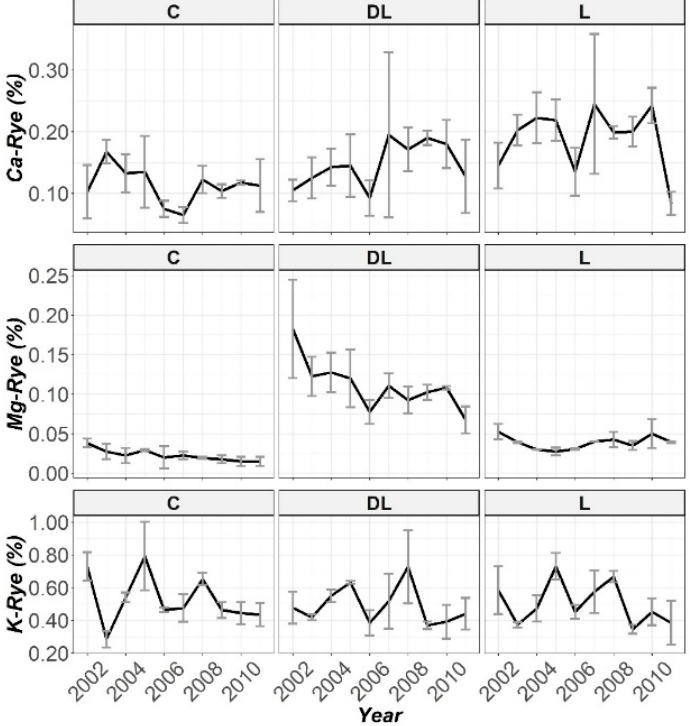
Figure 7. Temporal evolution of the Ca, Mg and K levels in stems throughout the ten years of cation content during stem monitoring (2002–2011).